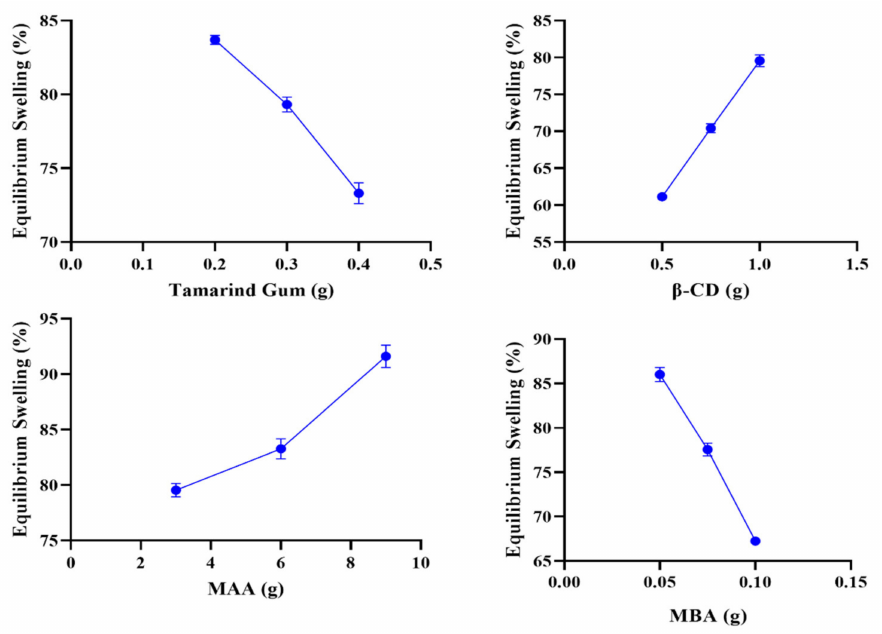
Figure 10. Effect of tamarind gum, β -CD, MAA, and MBA on equilibrium